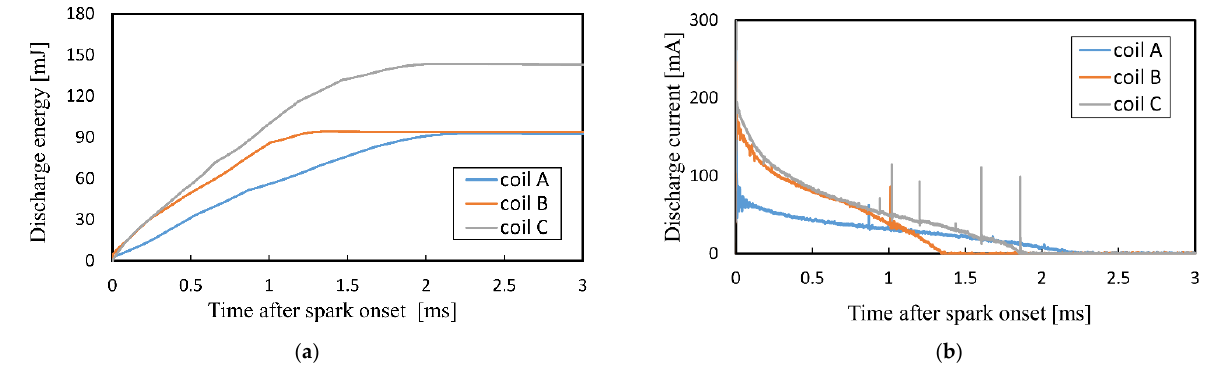
Figure 6. Discharge characteristics of the ignition coils. ( a ) Discharge energy; ( b ) Discharge current. Table 1. Detail specifications of the ignition coil.